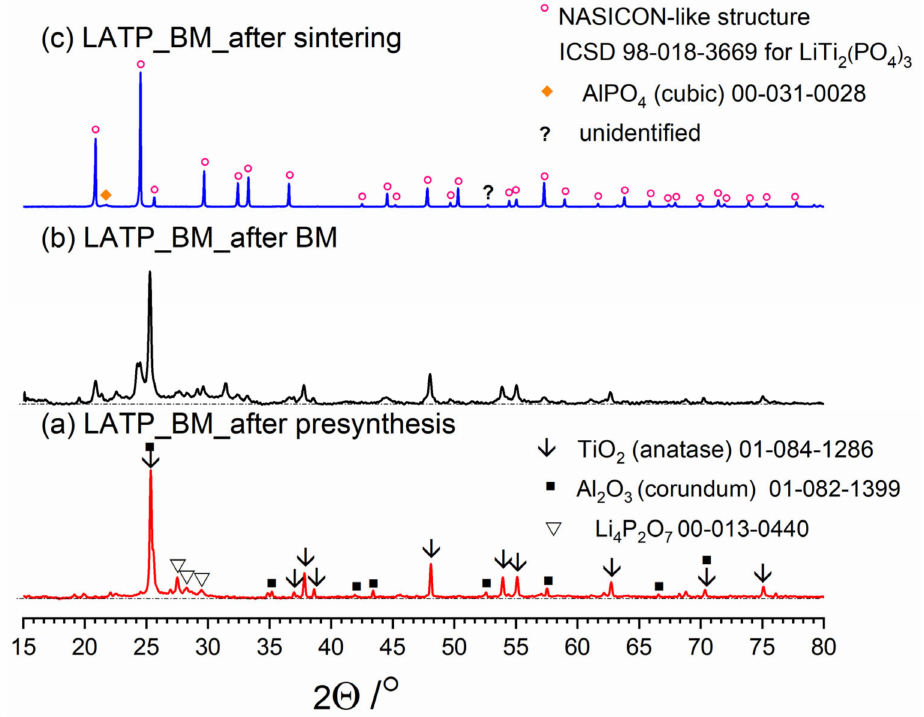
Figure 3. Diffractogrrams presenting different stages of LATP_BM_ceramic formation: ( a ) after presynthesis at 350 ◦ C for 3 h; ( b ) after ball-milling at 600 rpm for 72 h; ( c ) after heat treatment at 900 ◦ C for 12 h.